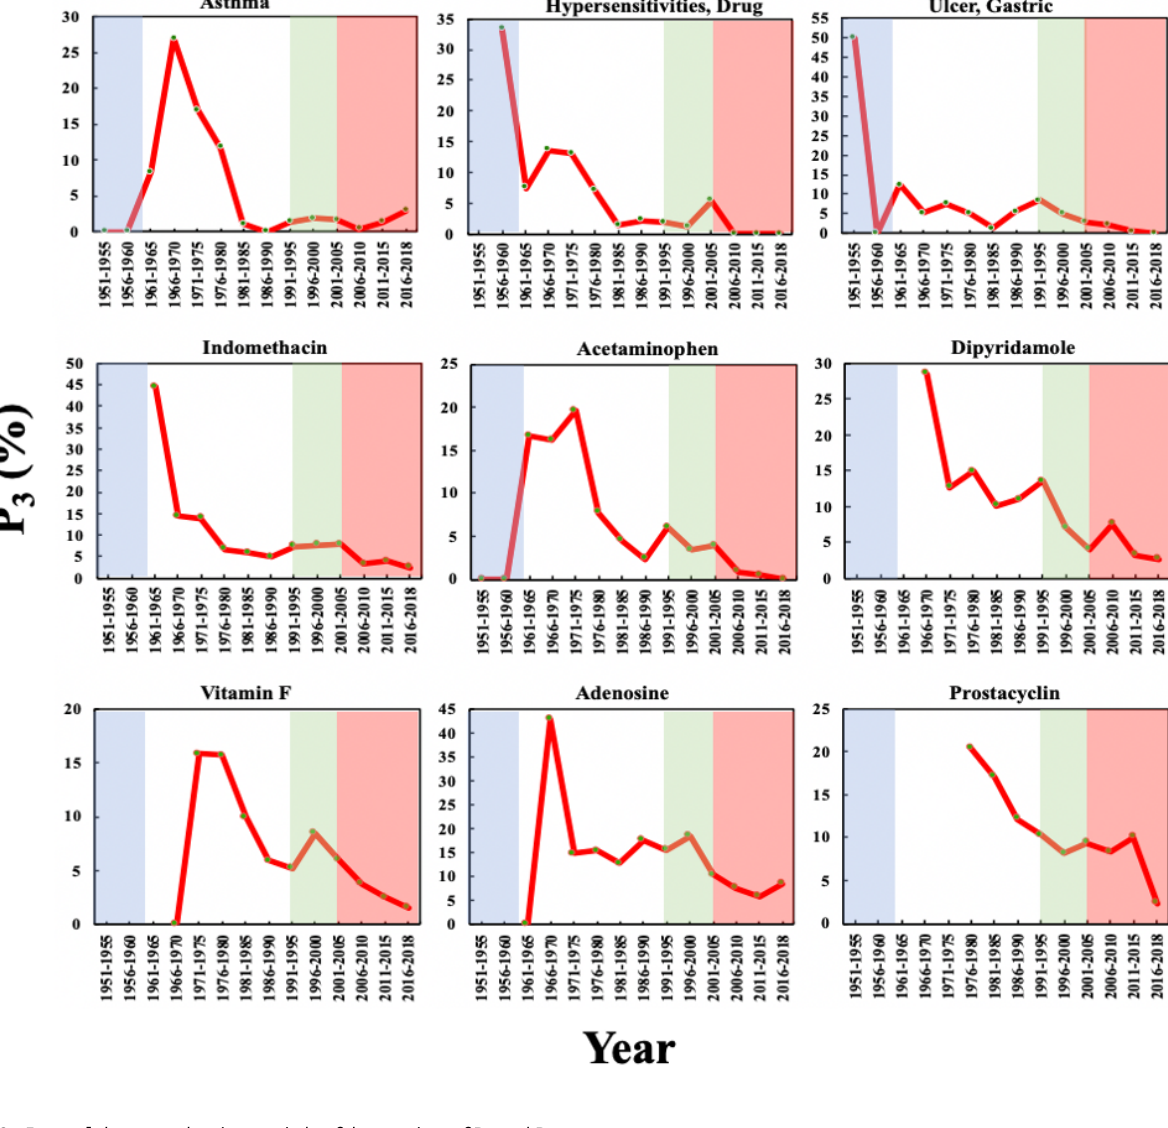
Table 3. Intervals between the time periods of the maxima of P 1 and P 3